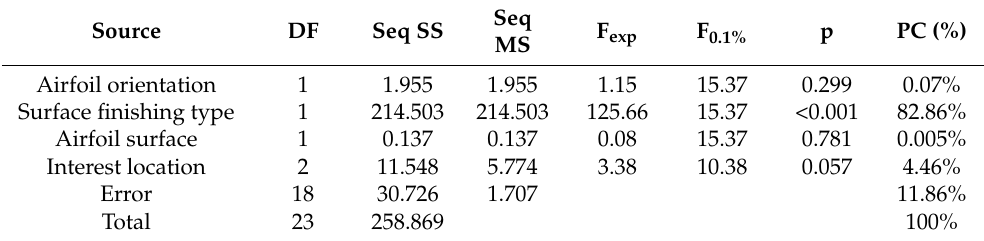
Table 4. The percentage contribution ratio based on generalized linear model (GLM).